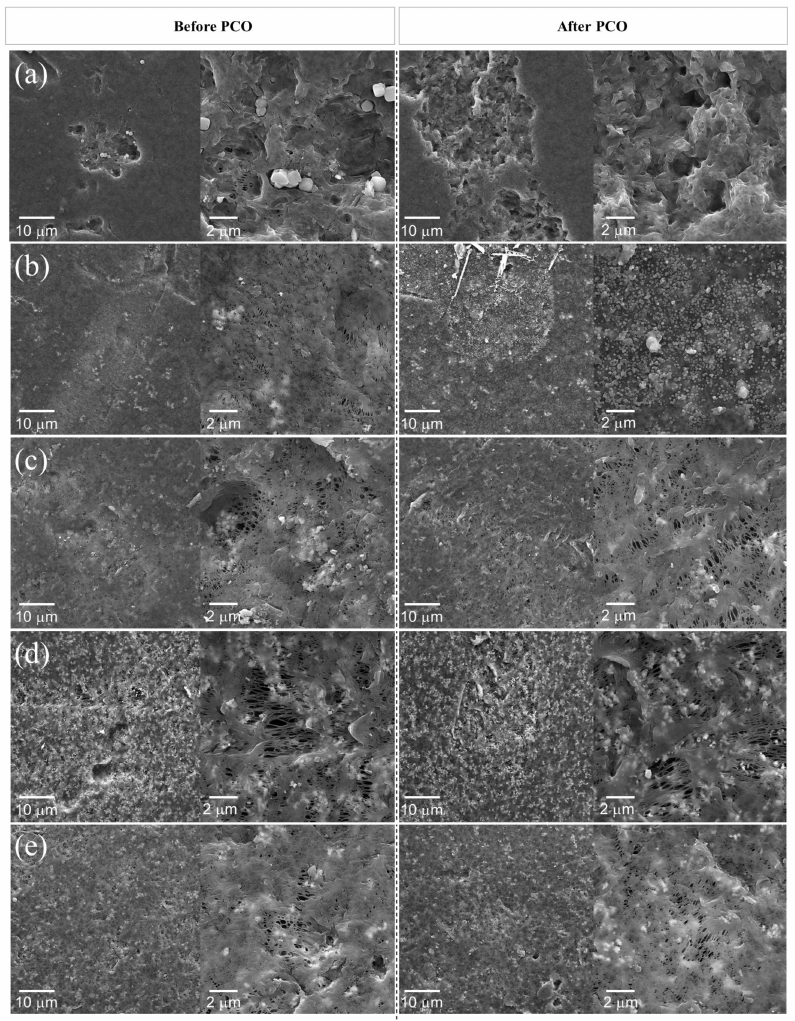
Figure 5. SEM images for samples before and after n -decane photocatalytic oxidation: ( a ) P-1, ( b ) PZ-1, ( c ) PVZ-1, ( d ) PVZ-4, and ( e )